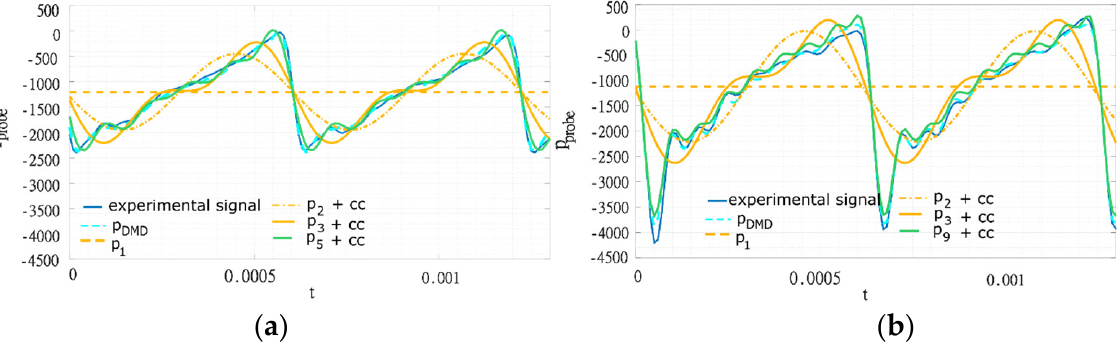
Figure 5. Partial DMD reconstruction; p 1 : least-squares fit, p i + cc: DMD modes plus complex conjugate (cc) up to i th order. ( a ) 11 modes 5 kg/s without grid; ( b ) 19 modes 5 kg/s with 60° grid.